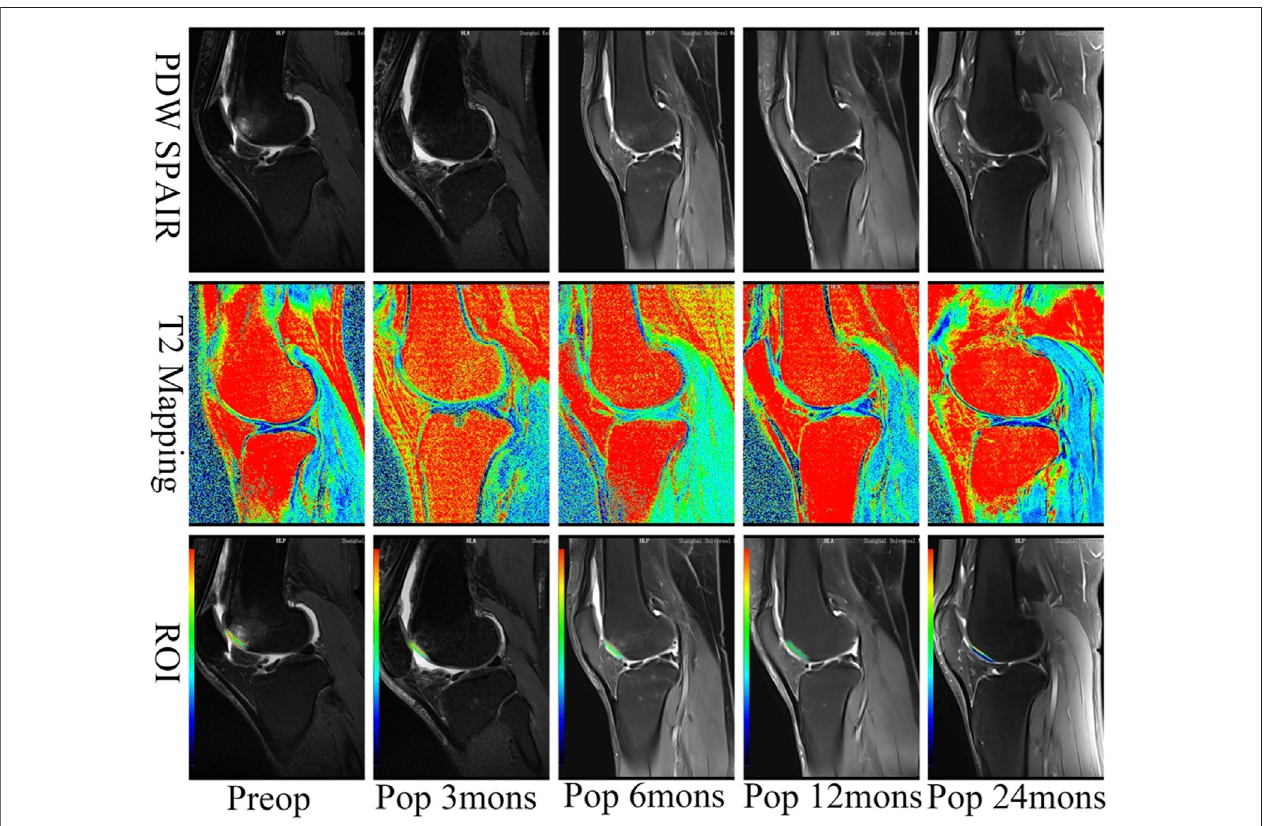
FIGURE3| T2mappingofcasesaftertheoperation.Thechondrallesiontreatedwiththeimplantdeveloped anintensitysimilar tothesurroundingnormalcartilage over time. ROI, the region of interest. The minimum value of blue is 0 ms representing healthy cartilage; the maximum value of red is 100 ms representing damaged cartilage. PDW, proton density-weighted; SPAIR, spectral attenuated inversion recovery; mons, months.